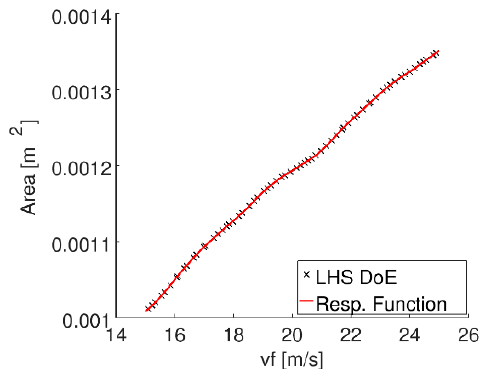
Figure 11. Plume cross-section area from DoE.